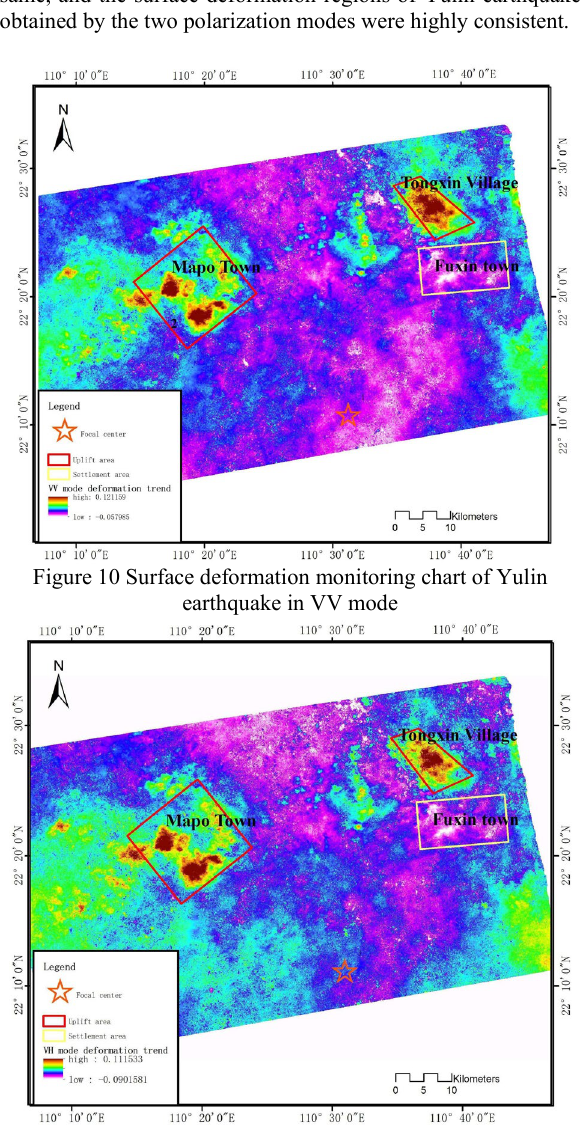
Figure 11 Surface deformation monitoring chart of Yulin earthquake in VH